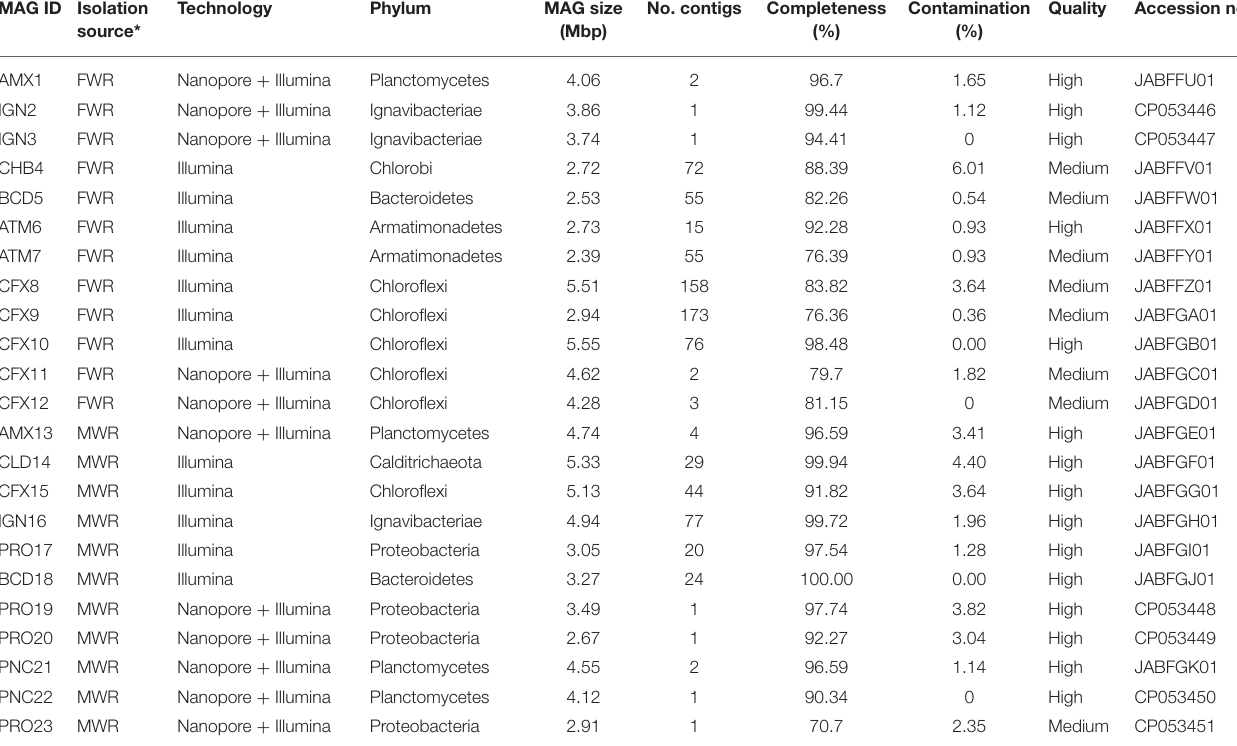
TABLE 1 | Characteristics of the Metagenome-assembled genomes (MAGs) obtained in this study. MAG ID Isolation Technology Contamination source*